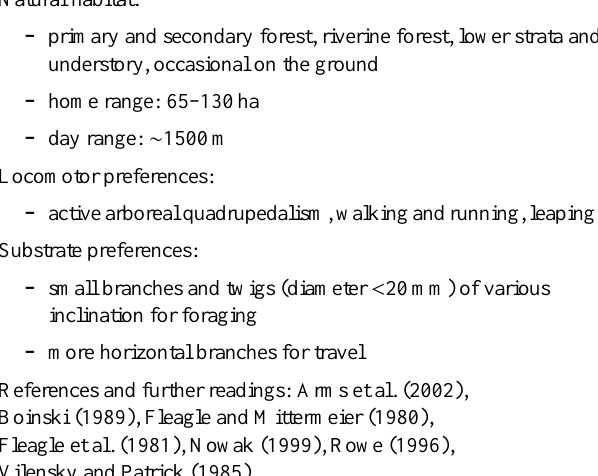
Figure for Box 4